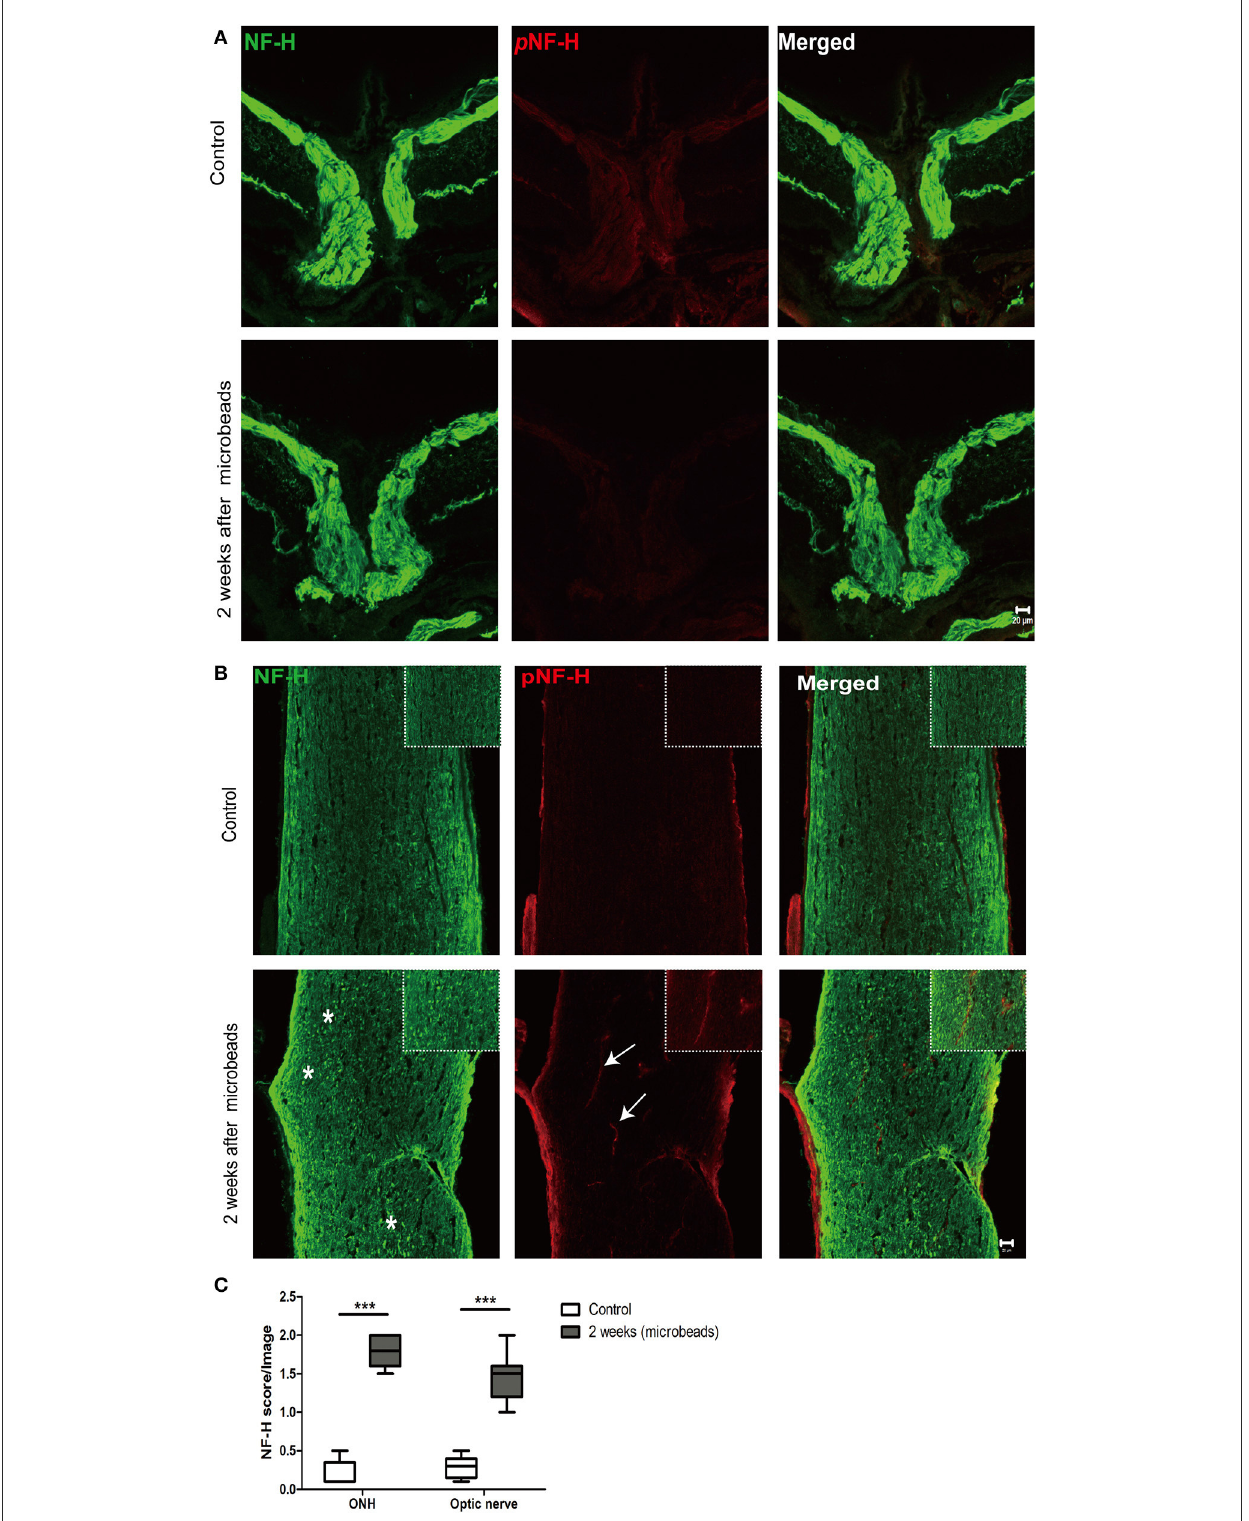
FIGURE7 Neurofilament degeneration first occurred at ONH and the optic nerve presented as local NF-H or pNF-H disconnection. (A) Feature double labeling immunofluorescence of pNF-H with NF-H at the site of ONH showing general neurofilament reduction and disconnection at the ONH after 2 weeks, Scale bars: 20 µ m. (B) Longitudinal optic nerve cryostat sections were harvested and used for immunohistochemistry of pNF-H and NF-H. Two weeks after COH, the neurofilament showed disconnection and dispersed into granular ones (asterisk), with arrows showing local pNF-H disconnection; high magnification images are shown in the top right of each lower magnification picture. Scale bars: 20 µ m. (C) An established scoring system was used for the quantification of neurofilament disconnection. The detailed score is shown in the box-and-whisker plots and a higher score is displayed in COH. N = 5 for each group, *** P <